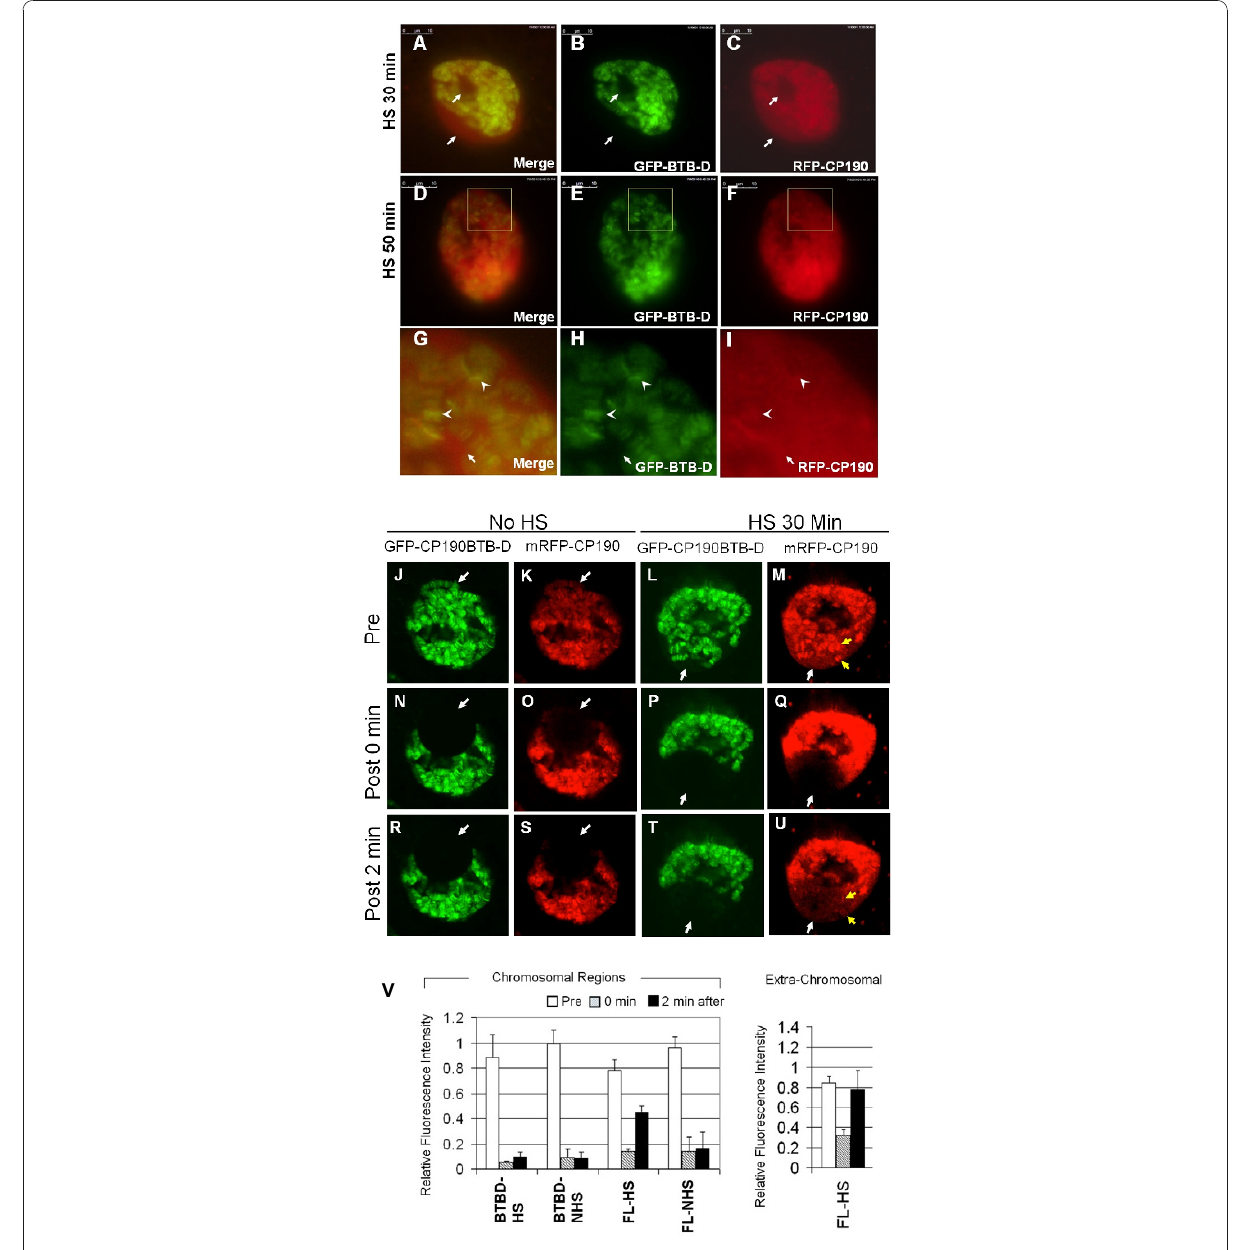
Figure 7 The full sized Cp190 dissociated from polytene chromosomes during heat-shock while the CP190BTB-D fragment remained bound . (A-I) Salivary glands dissected from 3 rd instar larvae expressing both mRFP-CP190 and GFP-CP190BTB-D proteins were treated with heat- shock for 30 minutes (A-C), for 50 minutes (D-I). (J-V) Salivary glands without heat-shock (J, K, N, O, R, S) or heat-shock for 30 mins (L, M, P, Q, T, U) were analyzed by the Fluorescence Recovery After Photobleach (FRAP) technique. The distribution of GFP-CP190BTB-D (green, B, E, and H) and the distribution of mRFP-CP190 (red, C, F, I) indicate that mRFP-CP190 dissociated from the chromosomes and was present in extra- chromosomal spaces (arrows). The squares in D, E, and F mark the region that is enlarged in G, H, and I. The arrow heads in G, H, and I points to two randomly sampled bands of GFP-CP190BTB-D on polytene chromosomes. (J-U) Salivary glands without the pretreatment of heat-shock (J, K, N, O, R, S) or heat-shocked for 30 minutes (L, M, P, Q, T, U) were analyzed by the FRAP technique. Images were taken before photobleaching (J, K, L, M), right after photobleaching (N, O, P, Q) and 2 minutes after photobleaching (R, S, T, U). White arrows point to areas that were photobeached. Yellow arrows point to bands reappeared after photobeaching. (V) Quantitative analysis of the fluorescence of GFP-CP190BTB-D (BTBD) and mRFP-CP190 (FL) before photobleaching (white bars), 0 minute (grey bars) and 2 minutes (black bars) after photobleaching from multiple nuclei (n > = 3) in heat-shocked treated (HS) or non-heat-shocked treated (NHS) salivary glands. The Relative Fluorescence Intensity (RFI) of chromosomal regions (left chart) and the RFI of the mRFP-CP190 in HS nuclei in extra-chromosomal regions (right